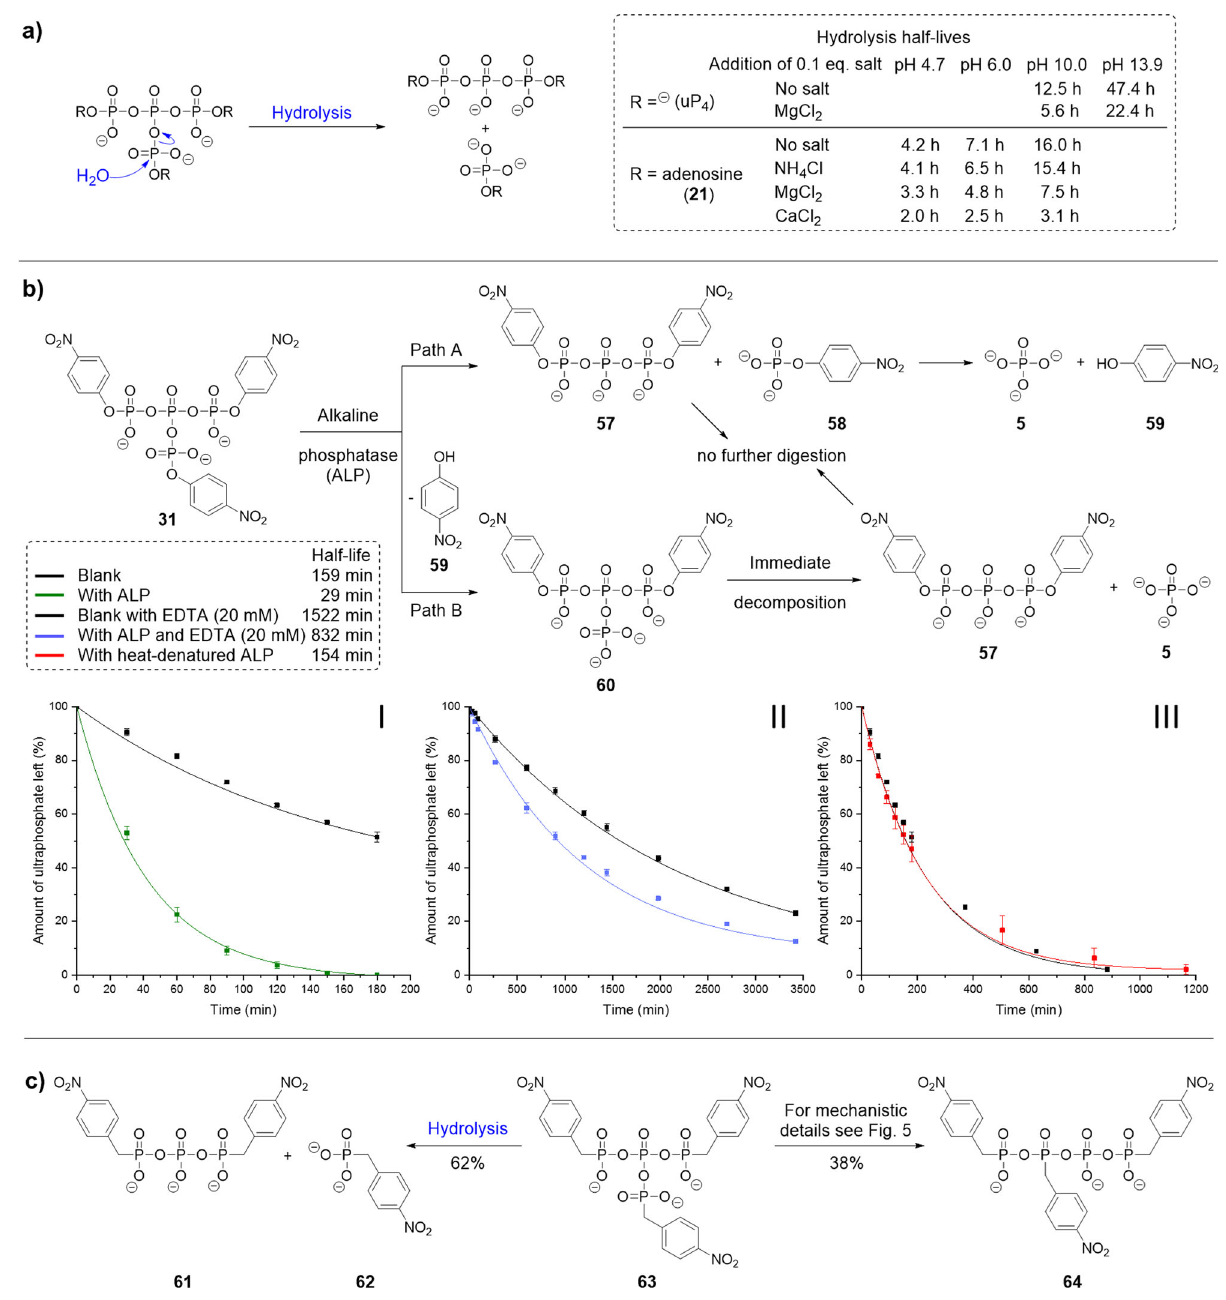
Fig. 4 Stability of ultraphosphates in aqueous media and enzymatic digestion. a Decomposition of trisadenosine ultraphosphate ( 21 ) and uP 4 under different pH values and in presence of 0.1 eq. of different cations. Half-lives were calculated assuming pseudo- fi rst-order reaction kinetics. b Enzymatic digestion of tris( para -nitrophenyl) ultraphosphate ( 31 ) by alkaline phosphatase (ALP) from bovine intestinal mucosa. Kinetics were recorded using 31 P{ 1 H}-NMR and the [PPN] signal was used as an internal standard. The results are means ± standard deviation from experiments performed in triplicates. Half-lives were calculated assuming pseudo- fi rst-order reaction kinetics. I , 31 in the presence (green) and absence (black) of ALP. II , 31 with 20 m M EDTA in the presence (blue) and absence (black) of ALP. III , 31 in the presence (red) and absence (black) of heat-inactivated ALP. c Decomposition of tris( para - nitrobenzyl phosphonyl) ultraphosphate ( 63